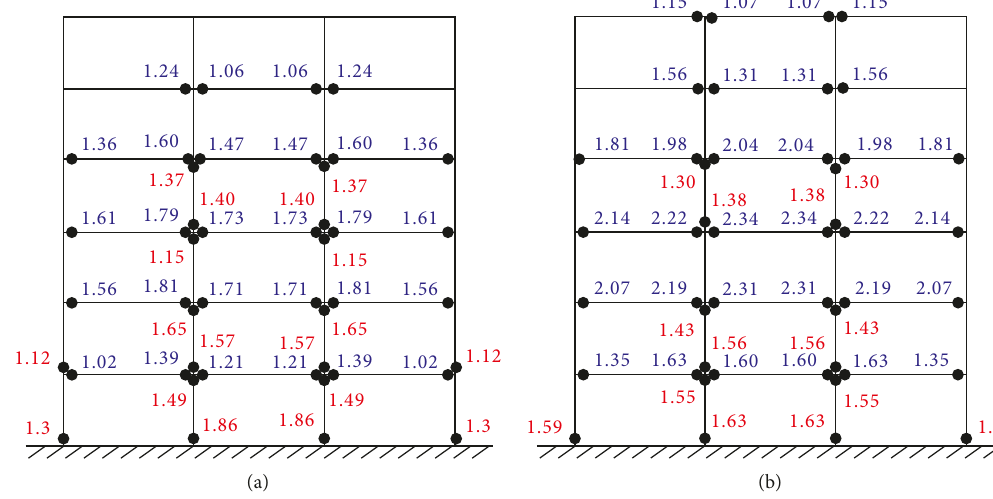
Figure 19: Plastic hinge distribution with 7-degree (0.15 g) fortification intensity. (a) Considering the beam-to-column linear stiffness ratio limit values. (b) Not considering the beam-to-column linear stiffness ratio limit values.